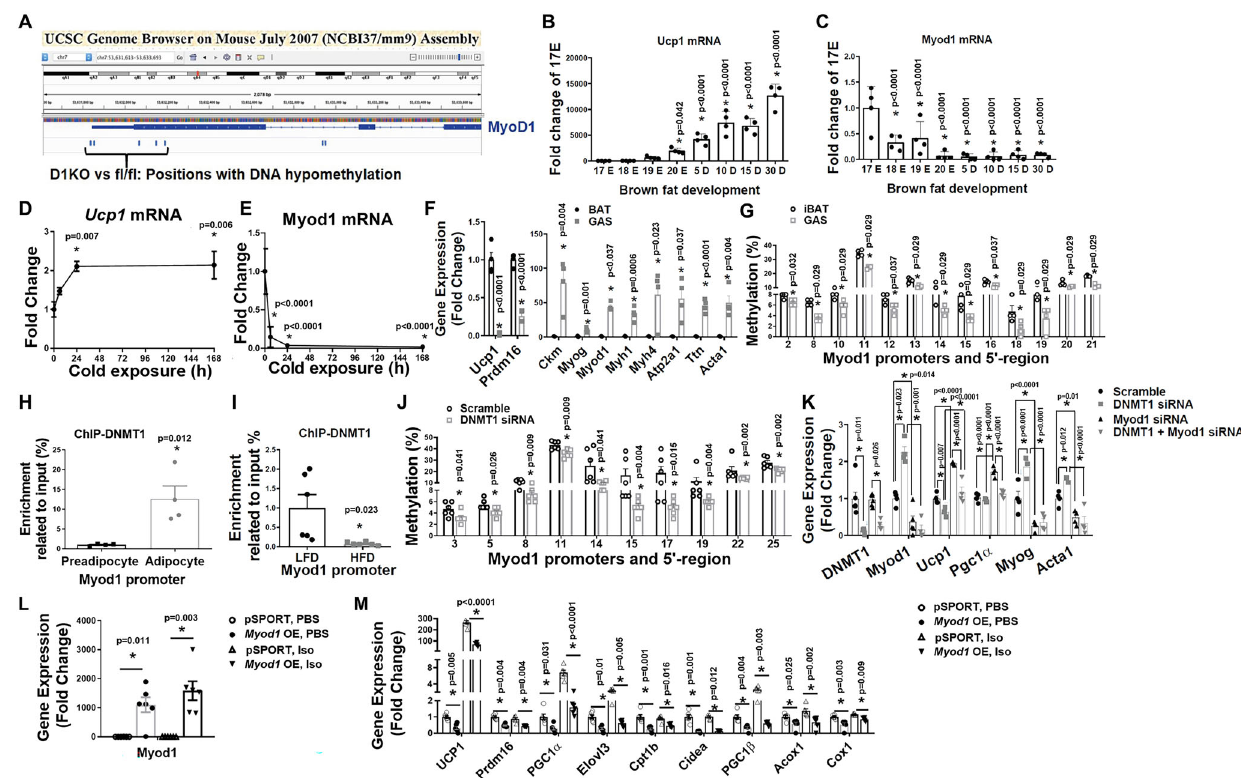
Fig. 7 MyoD1 mediates the effect of DNMT1 de fi ciency on brown fat myogenesis. A RRBS pro fi ling of DNA methylation level at MyoD1 promoter in iBAT of D1KO and fl / fl mice. B , C Ucp1 ( B , n = 4/group) and Myod1 ( C , n = 4/group) expression in iBAT of mice during late embryonic and